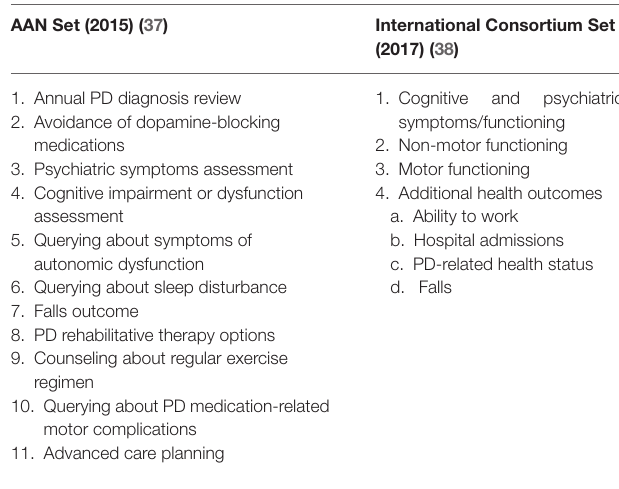
TABLE 1 | Quality and outcome measures for Parkinson’s disease